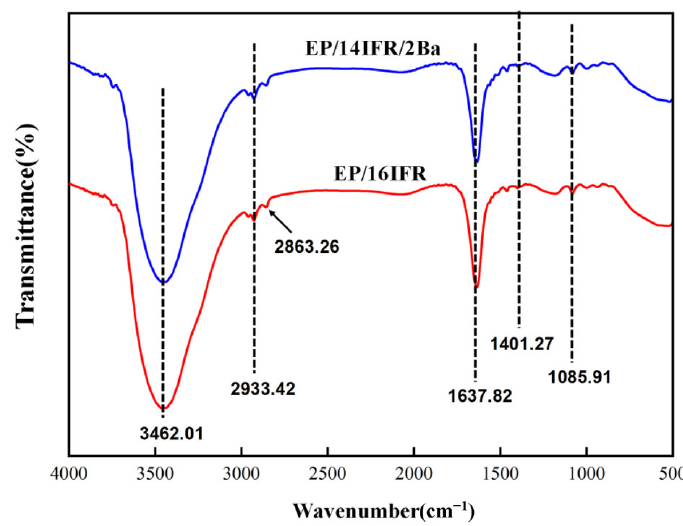
Figure 11. FTIR spectra of EP/16IFR and EP/14IFR/2Ba after combustion.